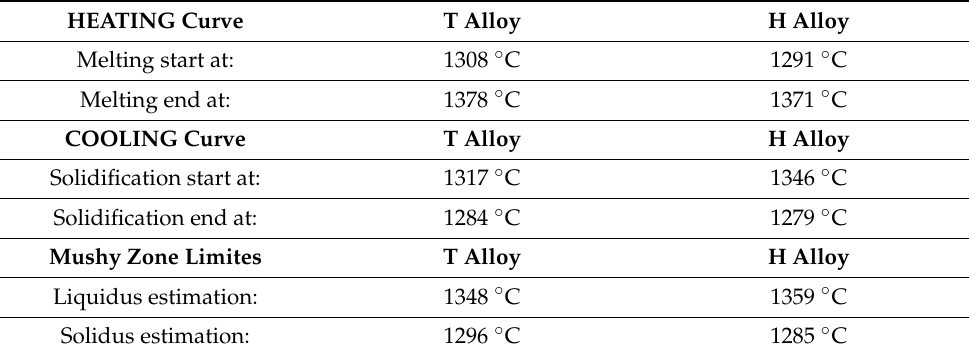
Table 2. Temperatures of start and end of melting and solidification (DTA at +5 and − 5 K min − 1 ); estimation of the solidus and liquidus temperatures for the two